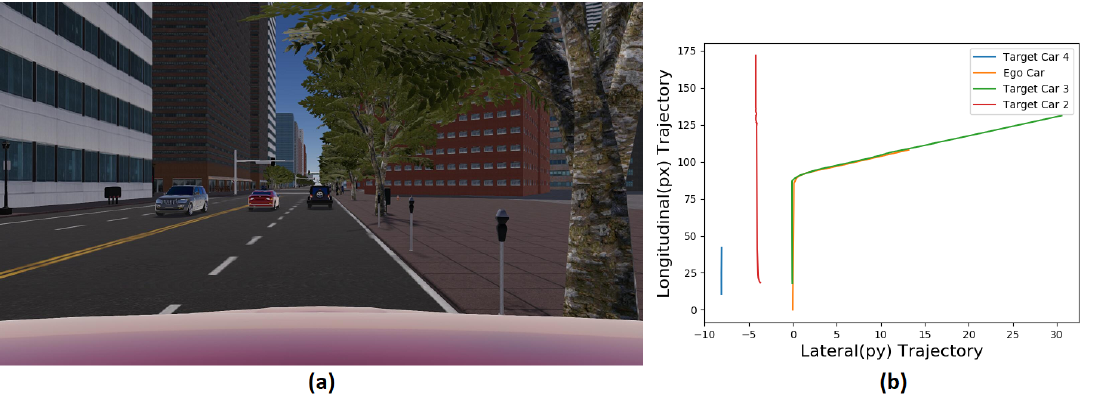
Figure 4. ( a ) LGSV L simulation front camera view starting position of the scenario. ( b ) Scenario from the start to the end of the simulation, with car trajectories for ego and target cars. In this scenario, the ego followed Target Car 3.